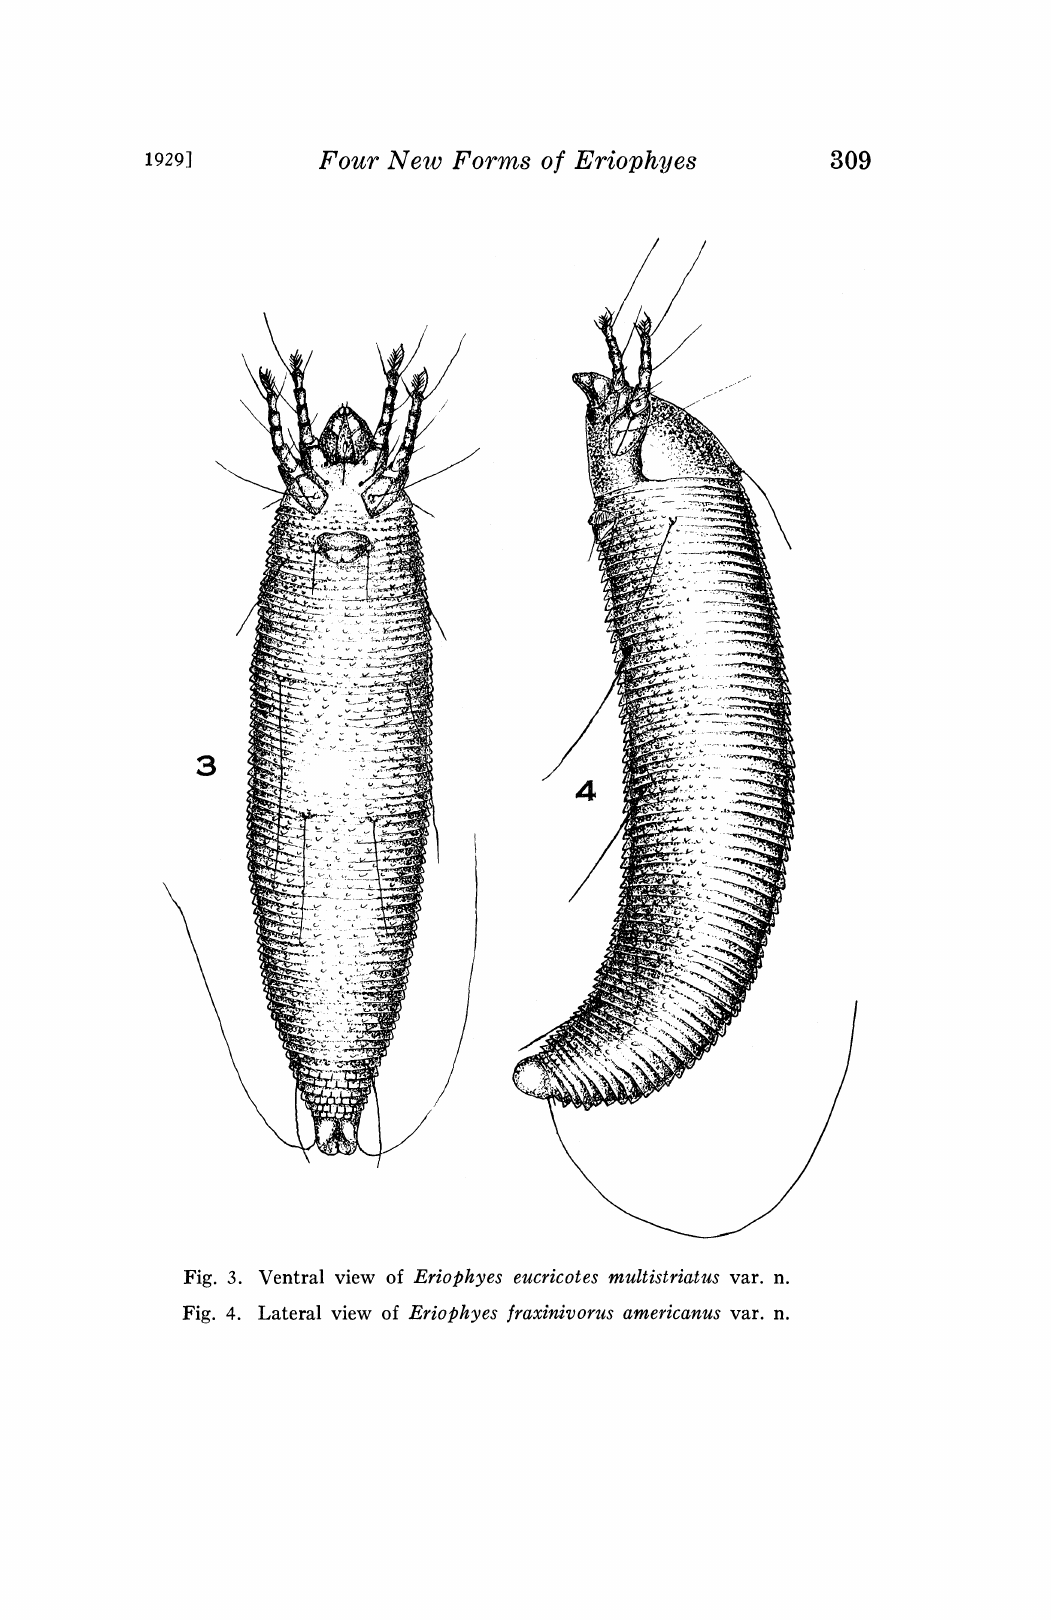
Fig. 3. Ventral view of Eriophyes eucricotes multistriatus var. n. Fig. 4. Lateral view of Eriophyes ]ra,xinivorus americanus vat.